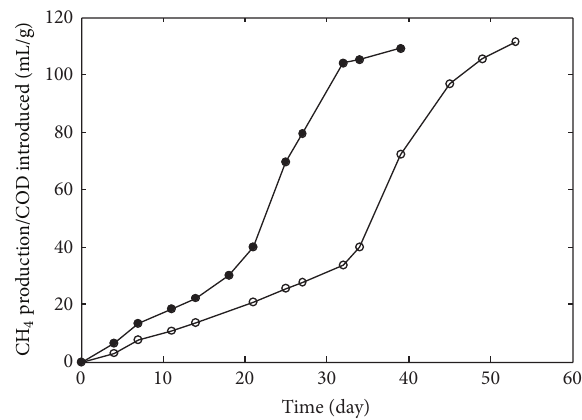
Figure 1: Methane production over time in un-spiked and spiked HLSS reactors. ( ∙ ) nonspiked HLSS, 𝑘 0.067 ± 0.003 day −1 HLSS, 𝑘 CH 4